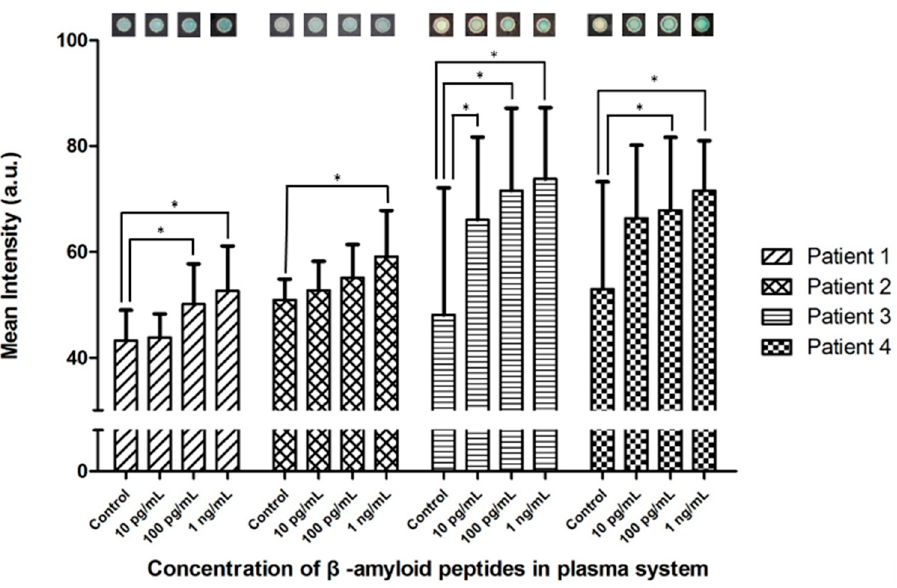
Figure 2. Colorimetric results (intensity) from a paper-based ELISA (P-ELISA) test for β -amyloid peptide 1–42 (A β 42) concentration in a plasma system. The secondary antibody used in plasma 1 and 2 was from Cell Signaling Technology, while that used in plasma 3 and 4 was from Abcam. The limit of detection (LOD) for tests using plasma 1 and 2 was approximately 100 pg / mL, while the LOD for tests using plasma 3 and 4 was about 10 pg / mL. (* p < 0.05). Table 1. Comparison between the two secondary antibodies used in our paper-based ELISA (P- ELISA) system for the detection of β -amyloid peptide 1–42 (A β 42).